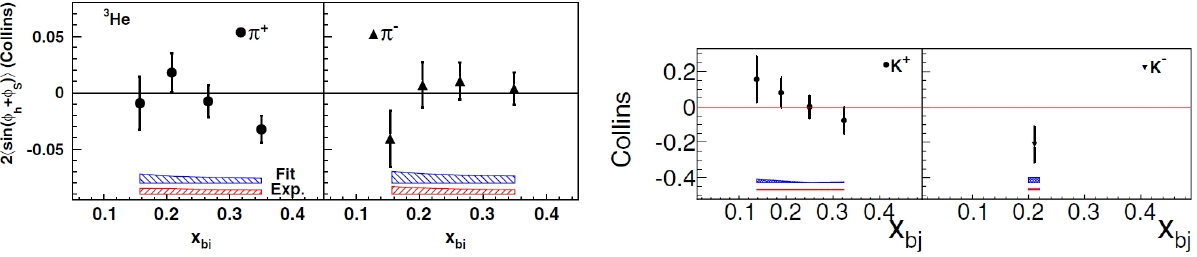
Figure 5. Hall A measurements of the Collins asymmetries on neutrons for π ± (left) and K ±